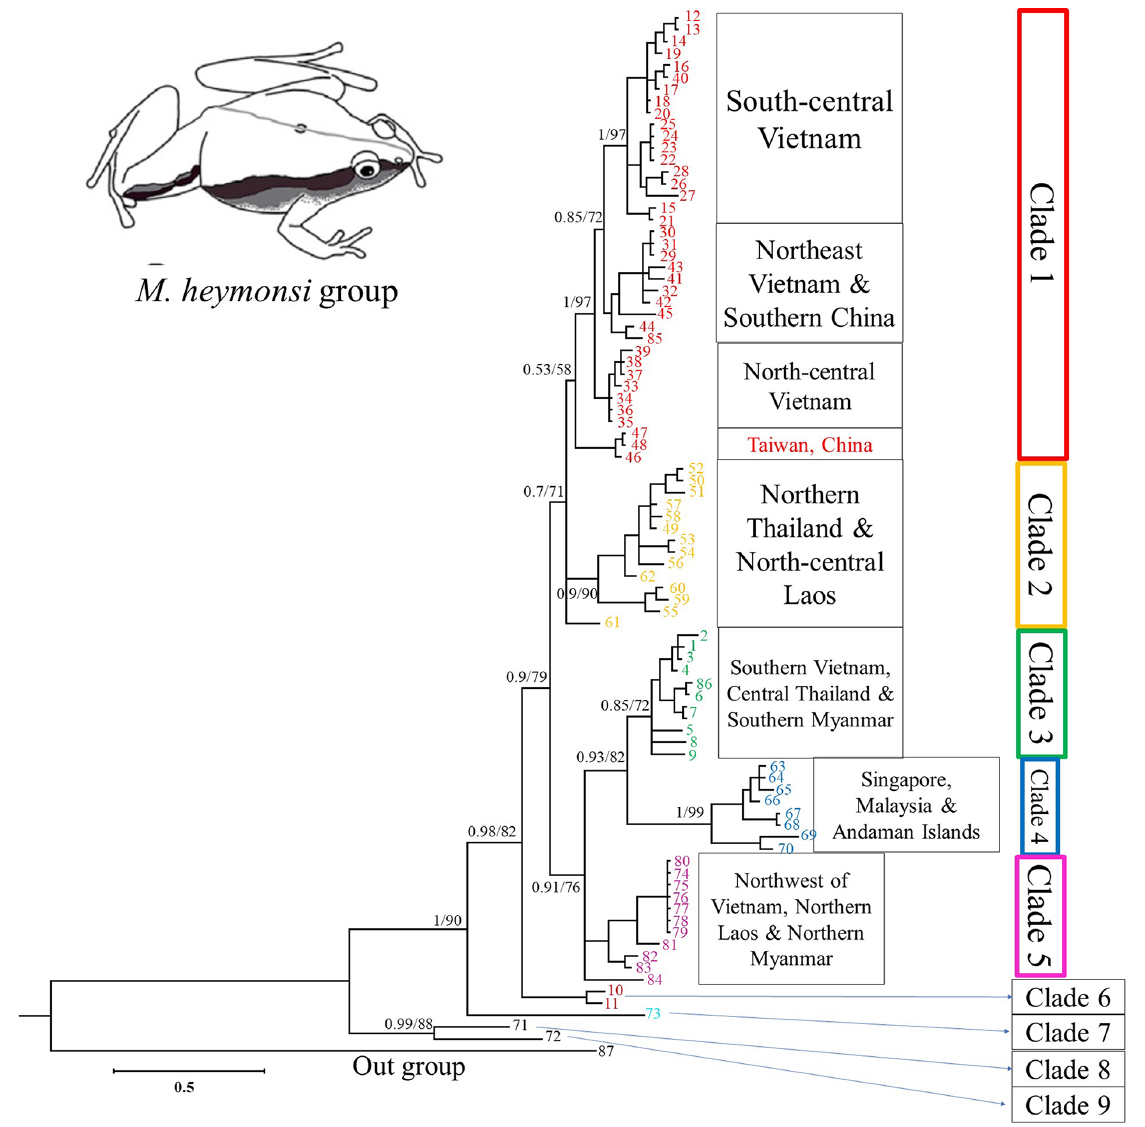
Fig. 3. Bayesian inference matrilineal genealogy of the Microhyla heymonsi group derived from the analysis of 16S rRNA mtDNA sequences. Numbers above and under branches are Bayesian posterior probabilities and ML bootstrap values; the scale bar represents 0.5 nucleotide substitutions per